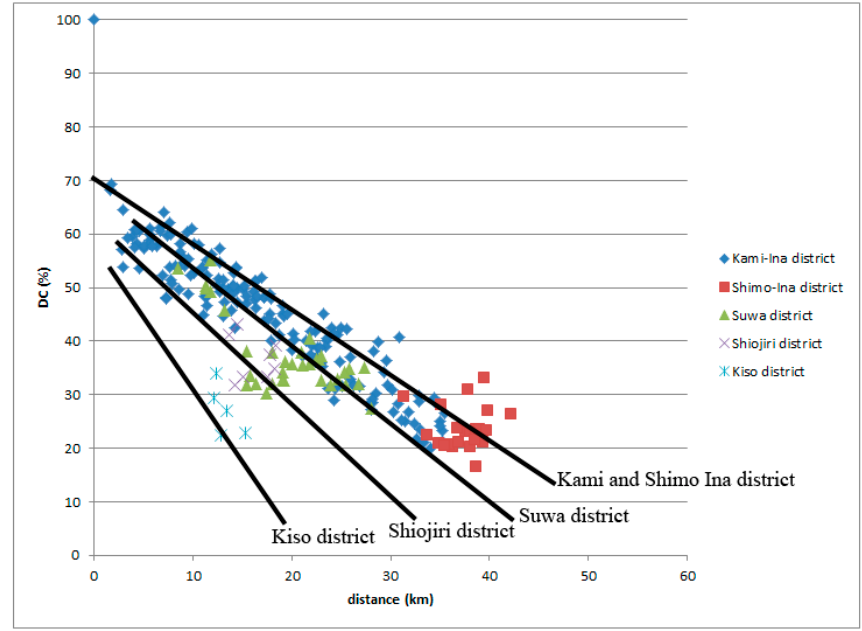
Figure 21. Kamiina-no Hogen data with reference place in Minowa, classified by comparison place. 7. Difference in the Relationships of Grammatical and Lexical Data between Wide and Narrow